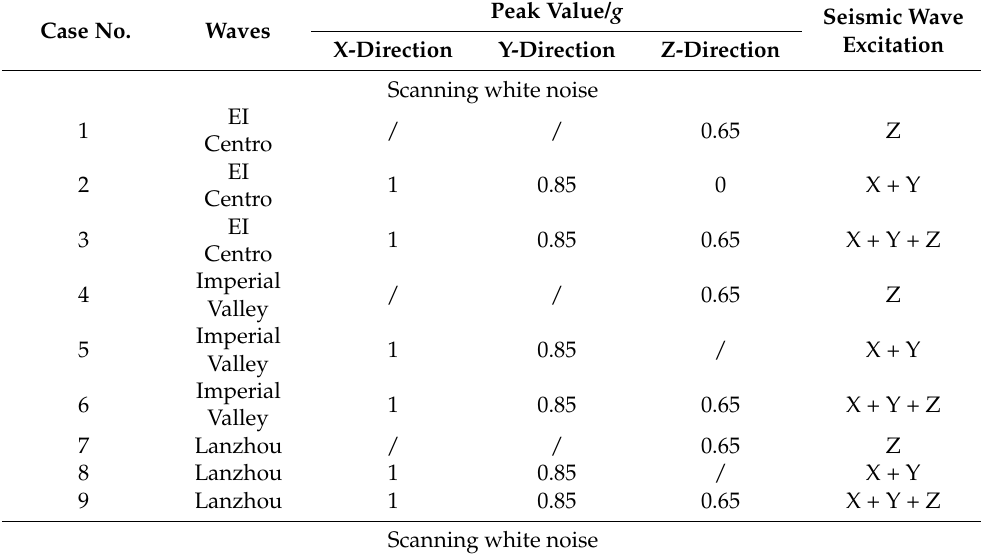
Table 3. Test cases.